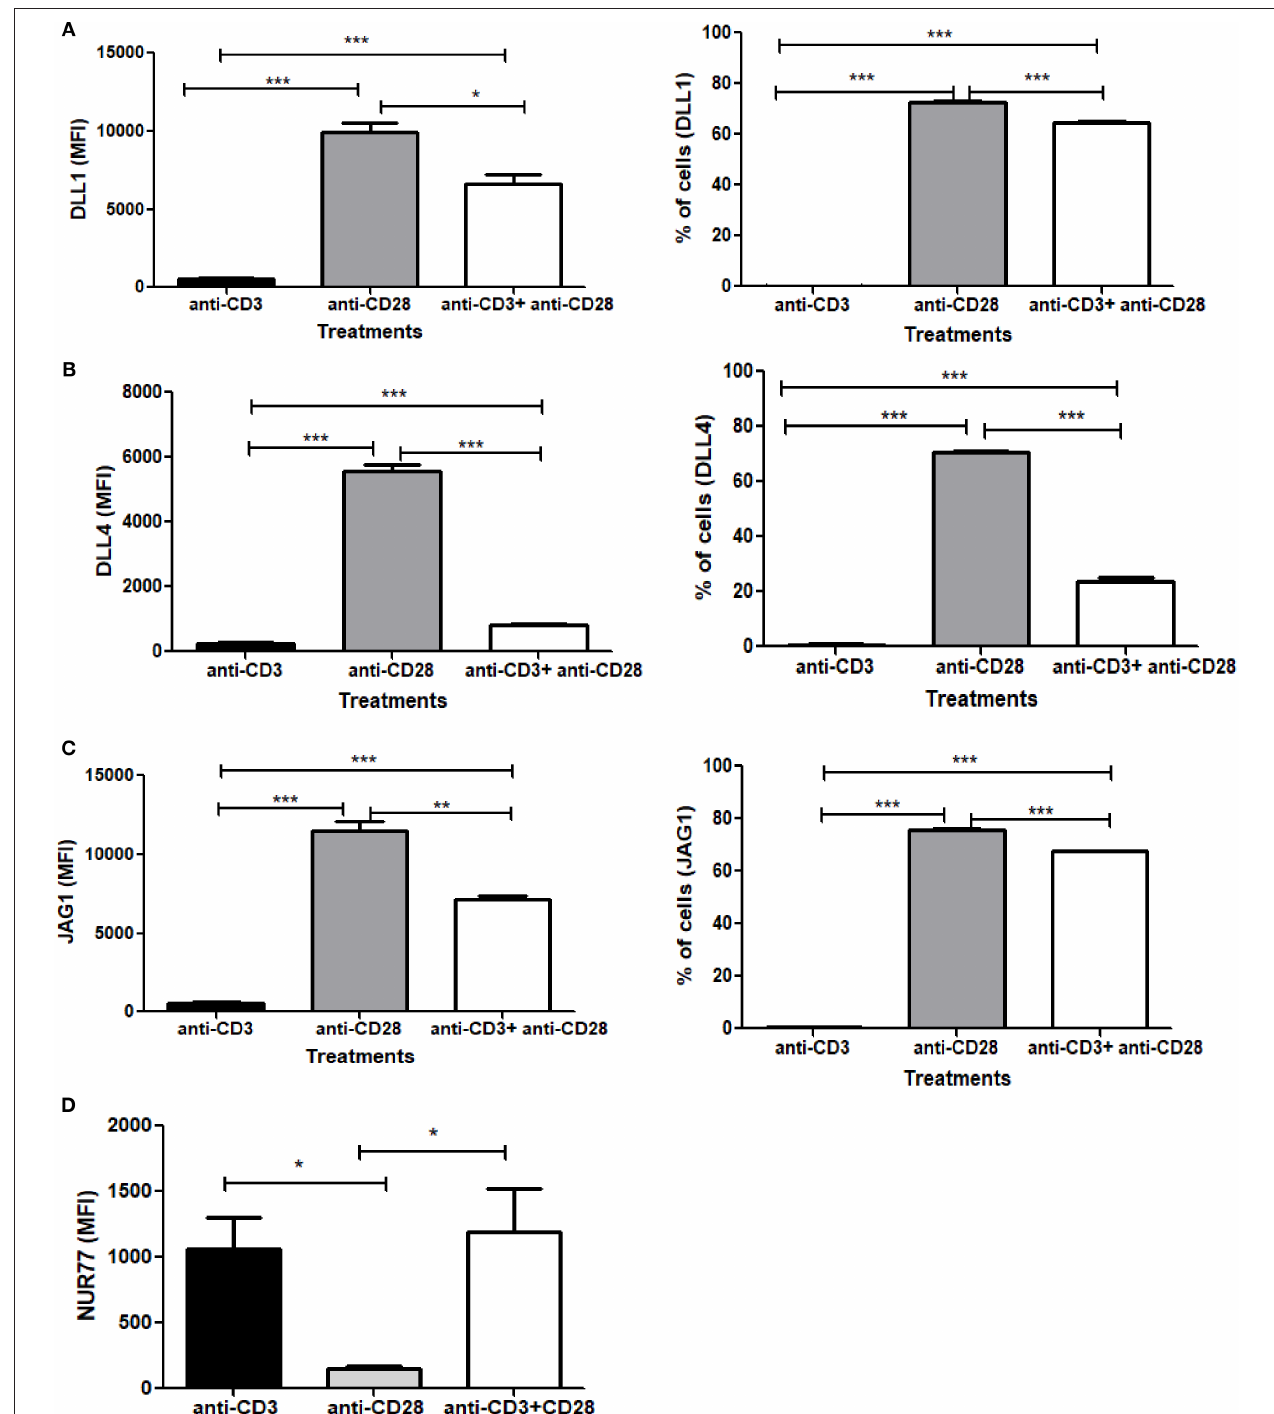
FIGURE 5 | Signaling through CD28 is sufficient to induce expression of Notch ligands on CD4T cells and signaling through CD3 suppresses ligand expression. CD4T cells from C57BL/6 mice were treated with soluble anti-CD3 ε alone or anti-CD28 alone or anti-CD3 ε and anti-CD28 for 6h. Cells were harvested and analyzed by flow cytometry by gating on live cell population as determined by absence of Zombie staining. MFI values and percentage of ligand positive cells were plotted for (A) DLL1, (B) DLL4, and (C) JAG1. (D) CD4T cells from Nur77-GFP reporter mice were treated with either soluble anti-CD3 ε or anti-CD28 or anti-CD28 and anti-CD3 ε together for 6h. Cells were harvested and analyzed by flow cytometry by gating on live cell population as determined by the absence of Zombie staining. Data represents three independent experiments Data represents mean ± SEM. * p < 0.05, ** p < 0.005, and *** p < 0.001.